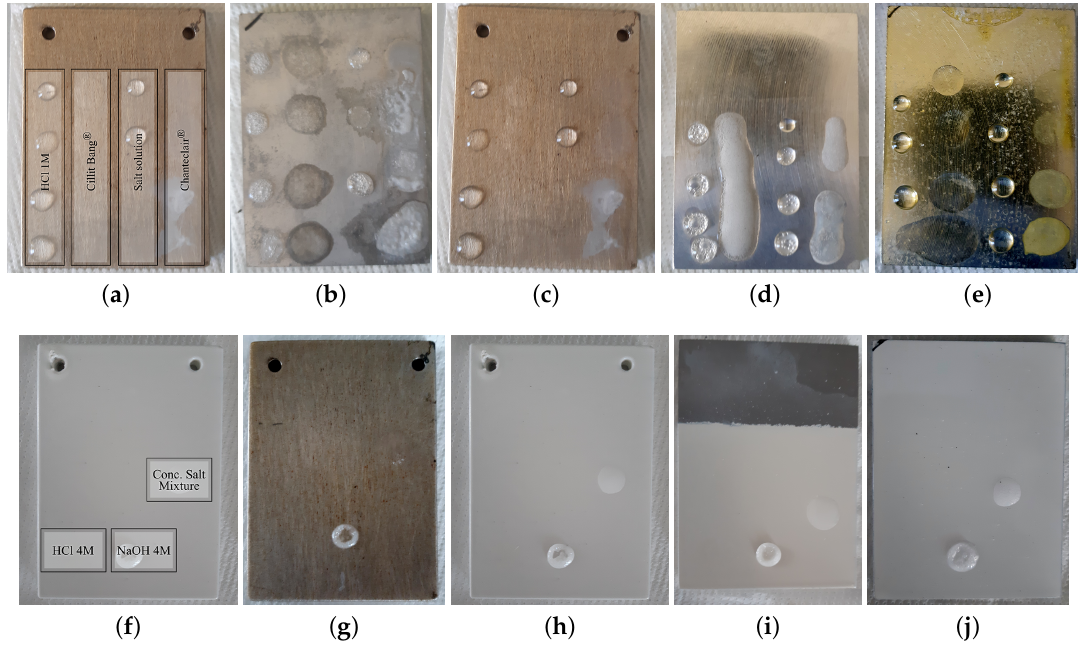
Figure 2. Selected planar samples at different stages of RT (top) and high temperature (bottom) drop tests: ( a , f ) show the scheme of the solutions used for the drop tests; ( b ) bare magnesium shown as a reference; ( c – e ) are transparent PA11, transparent nanoceramic and polyester coated samples respectively; ( g , h ) are transparent and white PA11 coated samples; ( i ) is the white siliconic coated sample; ( j ) is the white GSF lacquer 40µm coated sample. Bottom pictures are taken after the high temperature test in the oven, and the NaOH pellet formed during drop evaporation is